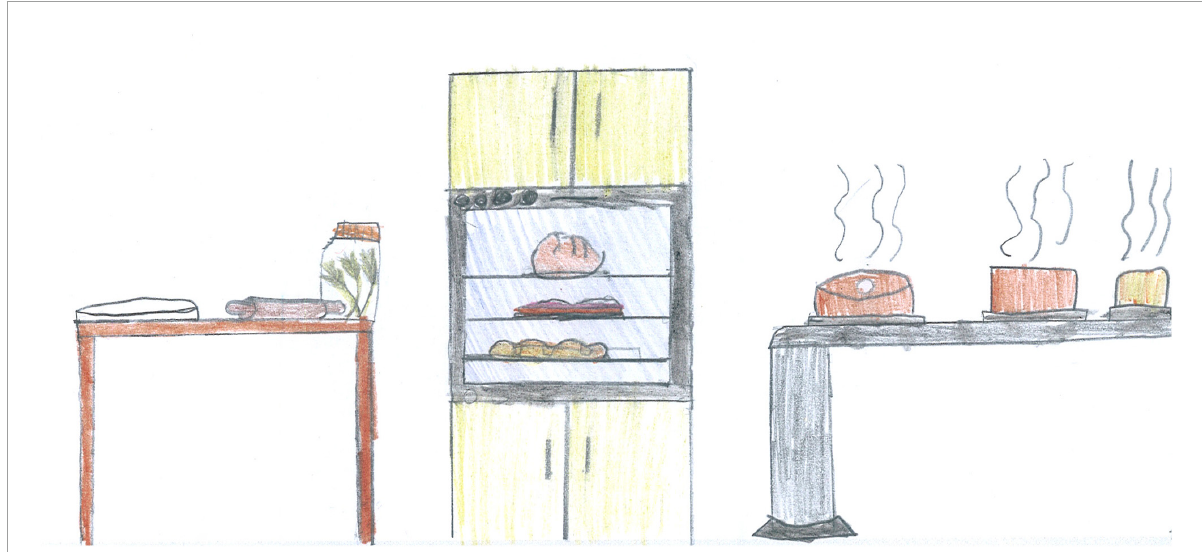
FIGURE5 An example of missing people; this time the depicted scene is the inside of the house. Someone must have prepared those cakes and surely is going to eat them soon (PS, Female, 10 years).